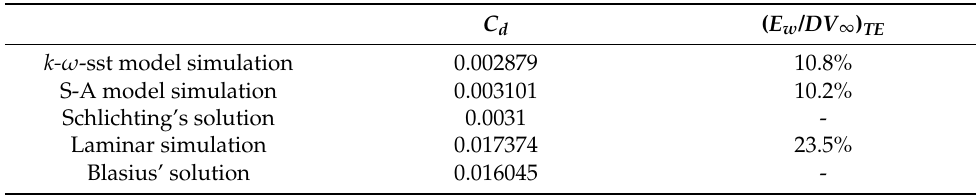
Table 5. Results of the 2D flat